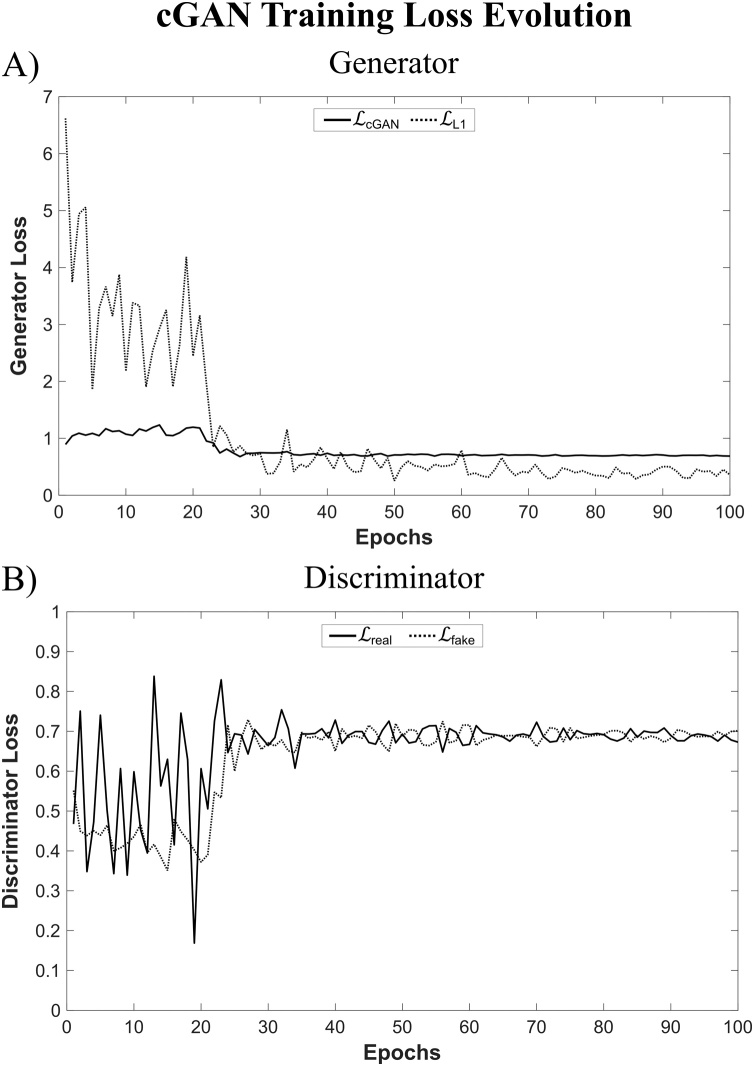
Loss Evolution during cGAN Training. The loss evolutions of the A) generator (LcGAN and LL1) and B) discriminator (Lreal and Lfake) are shown for a cGAN trained with a U-Net generator and a 1 × 1 PatchGAN discriminator for 100 epochs.